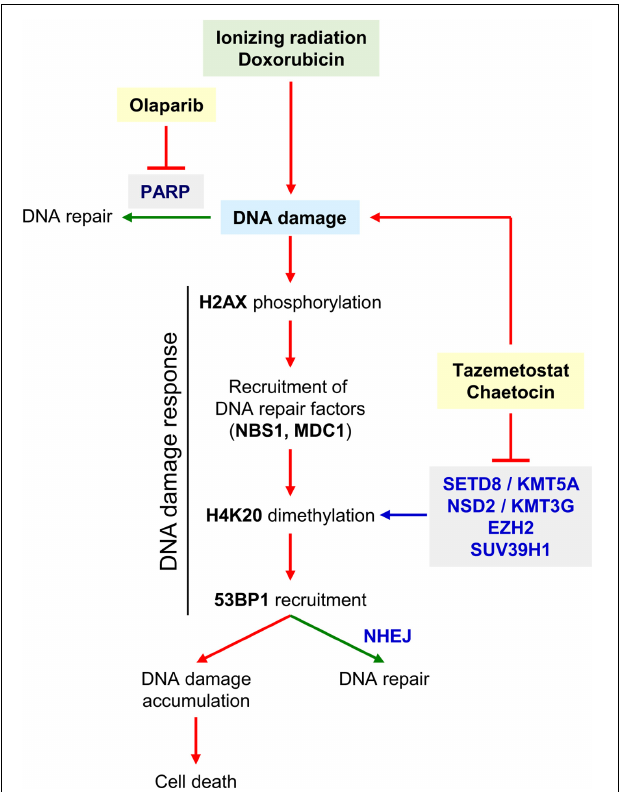
FIGURE 11 | Diagram showing the induction of DNA damage by radiation or doxorubicin, and the effect of KMT inhibitors on DDR. Both inhibitors promote the generation of DNA damage, impair its repair and thus contribute to facilitate tumor cell death. The SUV39H1, EZH2, SETD8, and NSD2, which mediate H4 lysine methylation, would be the most probable candidate enzymes inhibited by chaetocin and/or tazemetostat and explain why H4K20me2 levels decrease in presence of both KMT